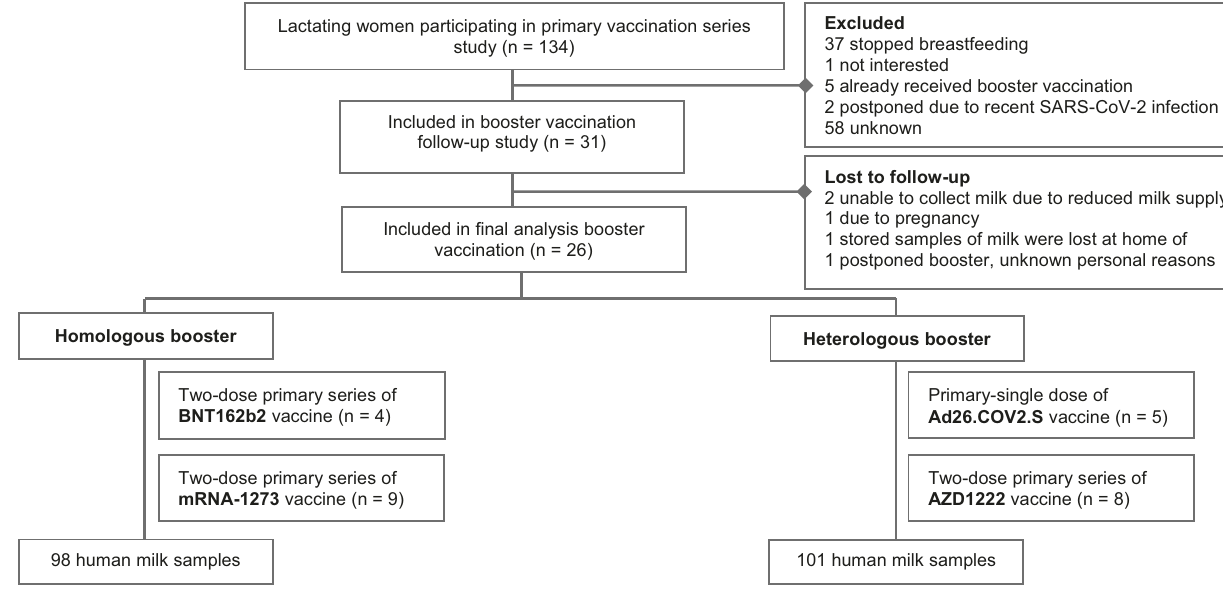
Fig. 1 Study fl owchart. Flowchart demonstrating the inclusion process of participants in the current